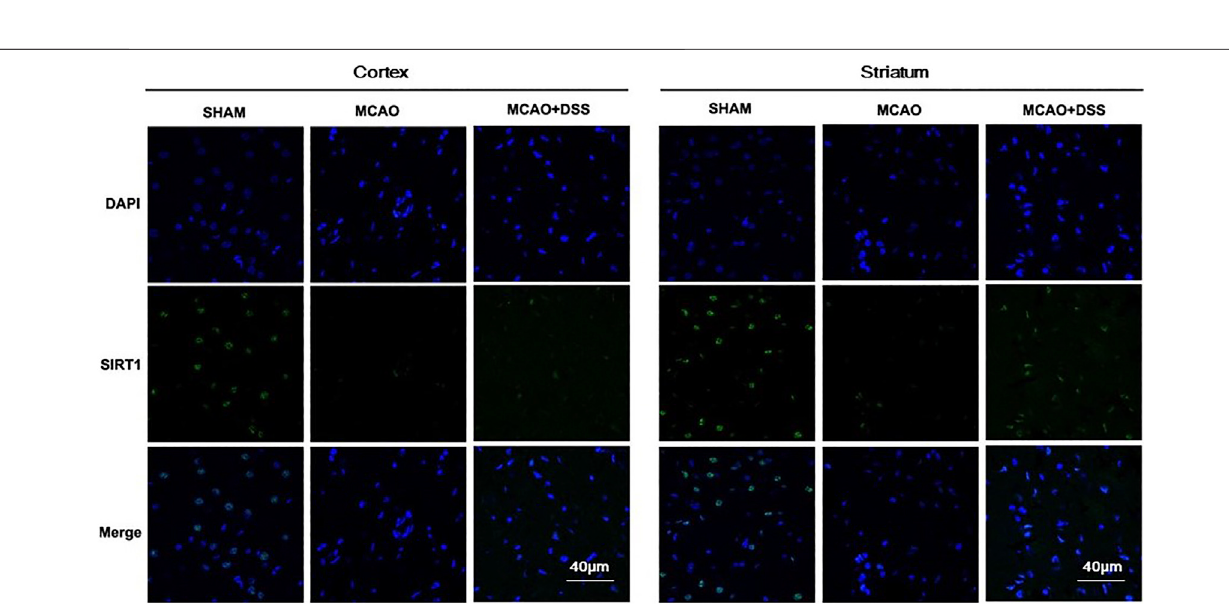
Frontiers in Pharmacology |